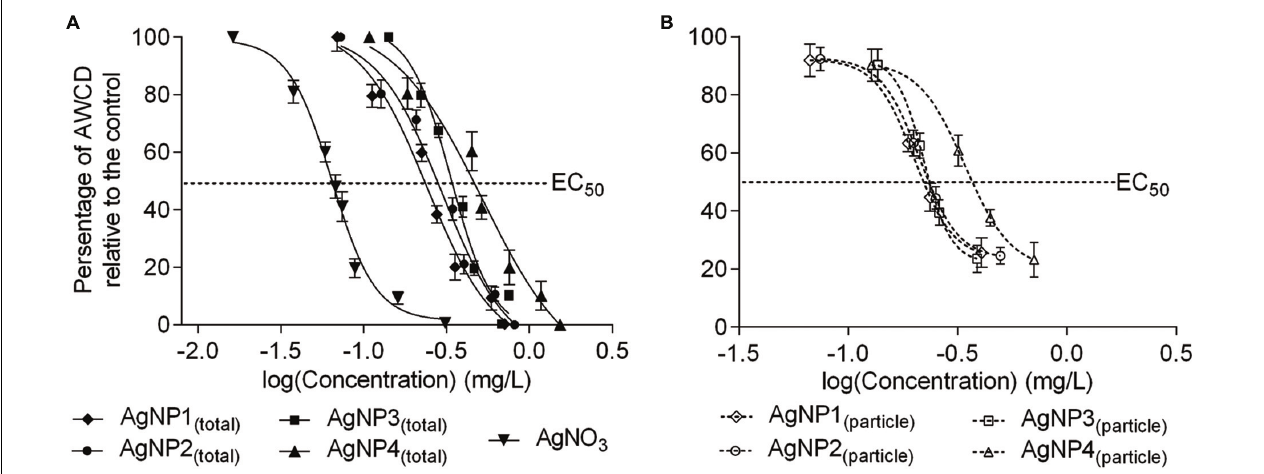
FIGURE 2 | Dose–response curves of average well color development (AWCD) of soil extracts exposed to suspensions of (A) AgNPs ( total ) and AgNO 3 , and (B) AgNPs ( particle ) expressed as time weighted concentrations. AWCD are plotted on the y -axis, actual log-transformed Ag concentrations are plotted on the x -axis. Data are mean ± SD ( n = 3). (AgNP1:50–80 nm nanoplates, AgNP2:15 nm nanospheres, AgNP3:20–40 nm nanospheres, and AgNP4:50 nm nanorods).